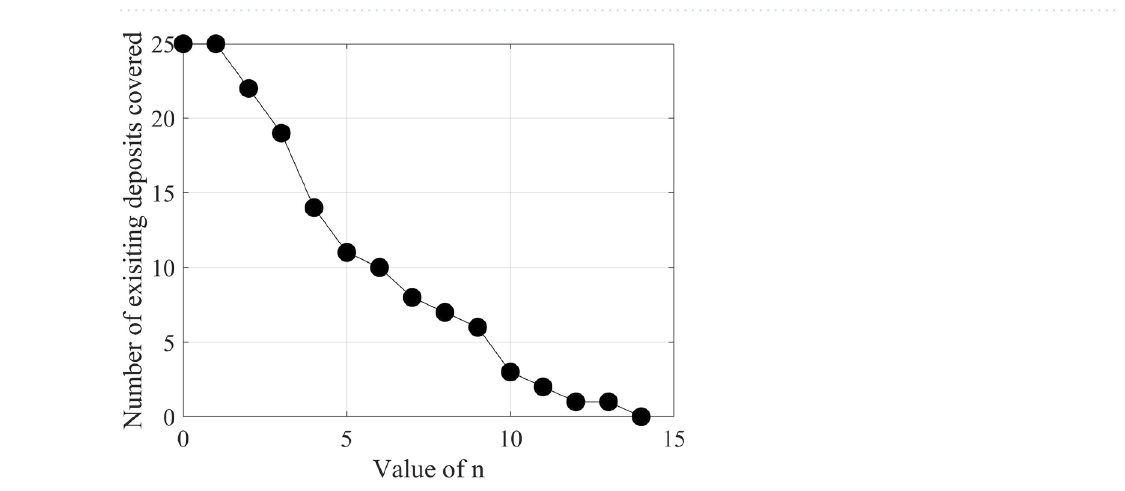
Figure 7. Probable petroleum deposits based on the existence of 1 to 16 votes over our 16 best-performing models from the matrix-based analysis (the figures are created using MATLAB 2021a 51 ).